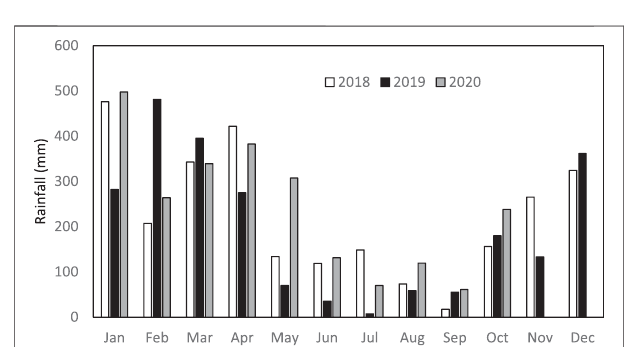
FIGURE 4 | Monthly rainfall for 2018, 2019 and 2020 (to October). Data from Palangka Raya meteorological station, Badan Meteorologi, Klimatologi dan Geo fi